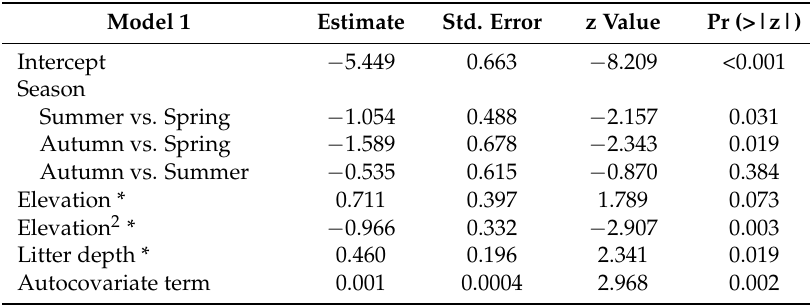
Table 3. Regression model for nymph counts per site in 2014. We used a negative binomial regression model with the log-transformed sampling distance as an offset.